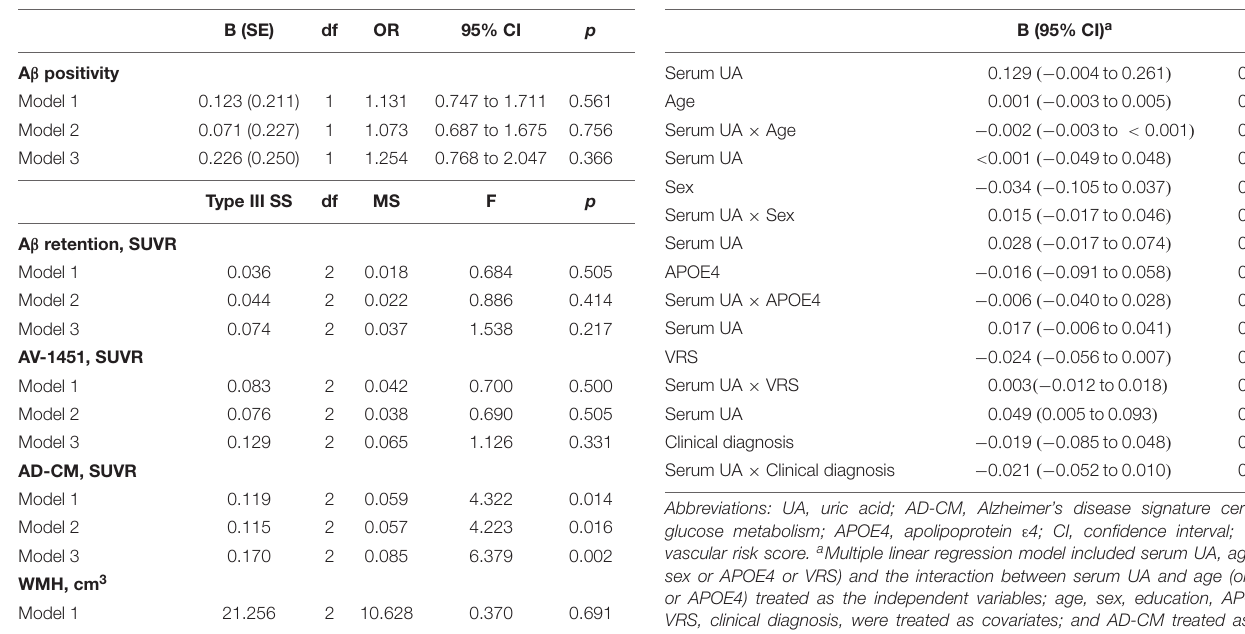
TABLE 6 | Results of multiple linear regression analyses including the interaction term between serum UA strata and age (or gender or APOE4 or VR score) status predicting AD-CM for non-demented older subjects.